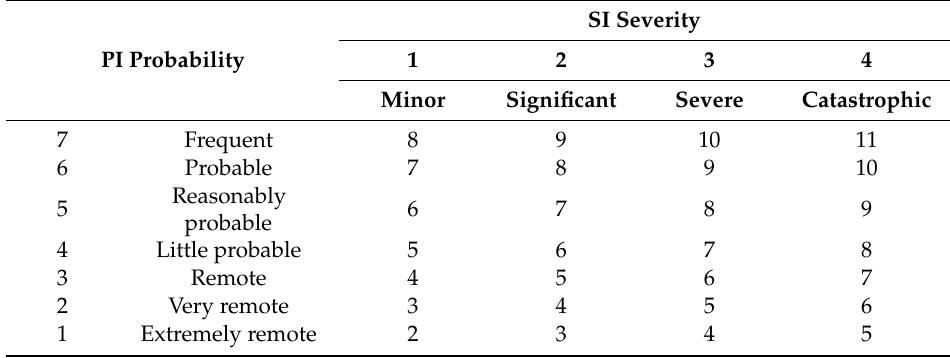
Table 3. Risk matrix